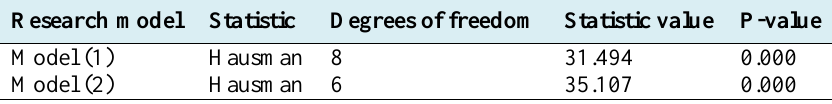
Table 19. The results of the Hausman test in the